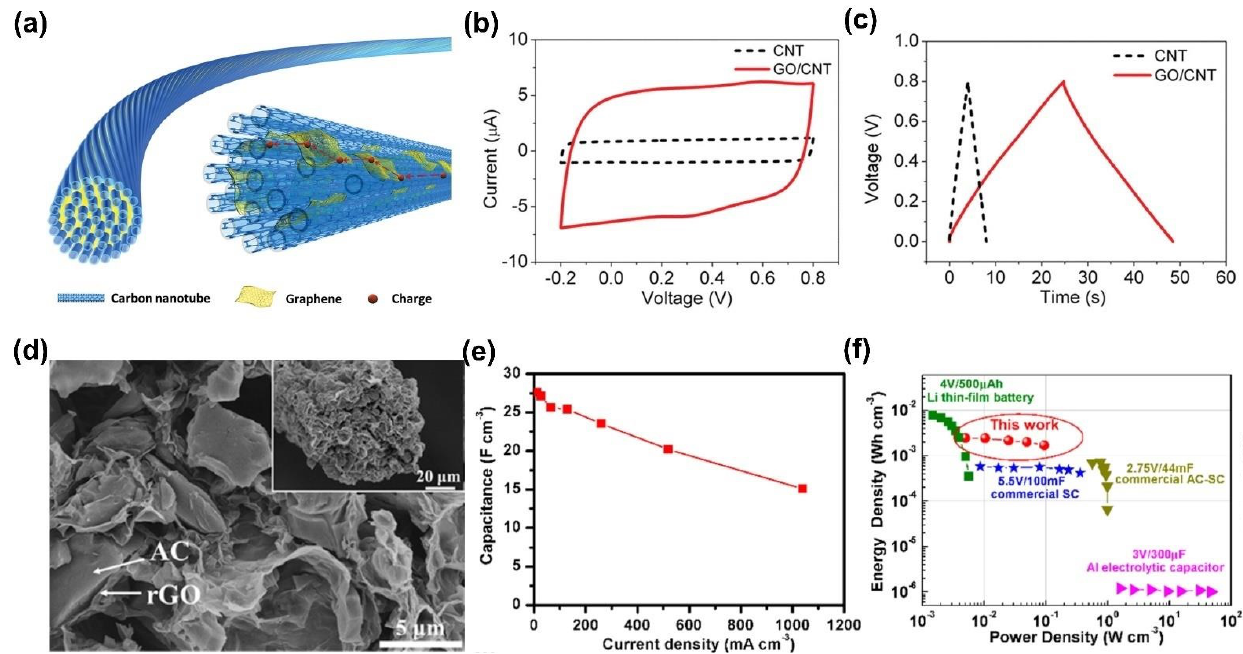
Figure 8. ( a ) Schematic illustration of the structure of the graphene/CNT composite fiber; ( b ) Current–voltage and ( c ) galvanostatic charge–discharge curves of wire-shaped supercapacitors with bare CNT and GO/CNT composite fibers as electrodes, respectively [93] (copyright permission Wiley-VCH 2014); ( d ) SEM image ofactivated carbon/rGOfibers; ( e ) Specific capacitance of AC fiber-based all-solid-state supercapacitors at various current densities; ( f ) Energy and power densities of the AC fiber-based all-solid-state supercapacitors compared with those of commercially available energy-storage systems [96] (copyright permission American Chemical Society 2016).